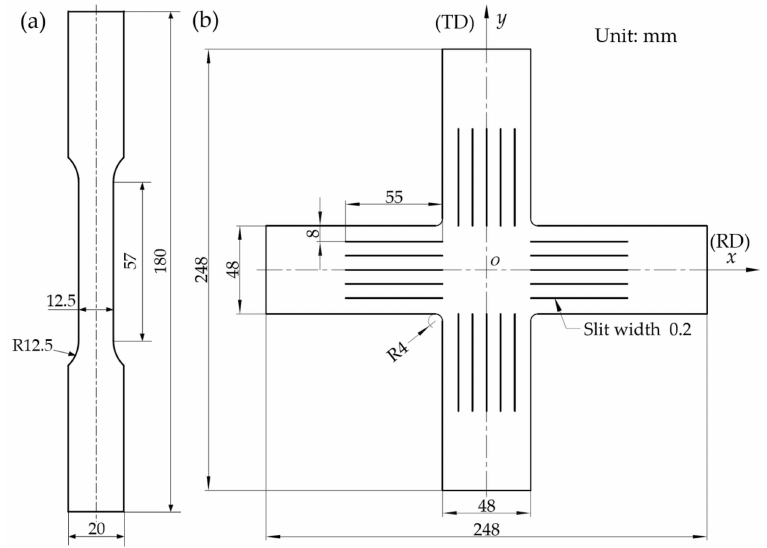
Figure 2. Geometries and dimensions of specimens in: ( a ) uniaxial; ( b ) biaxial tensile tests [8].